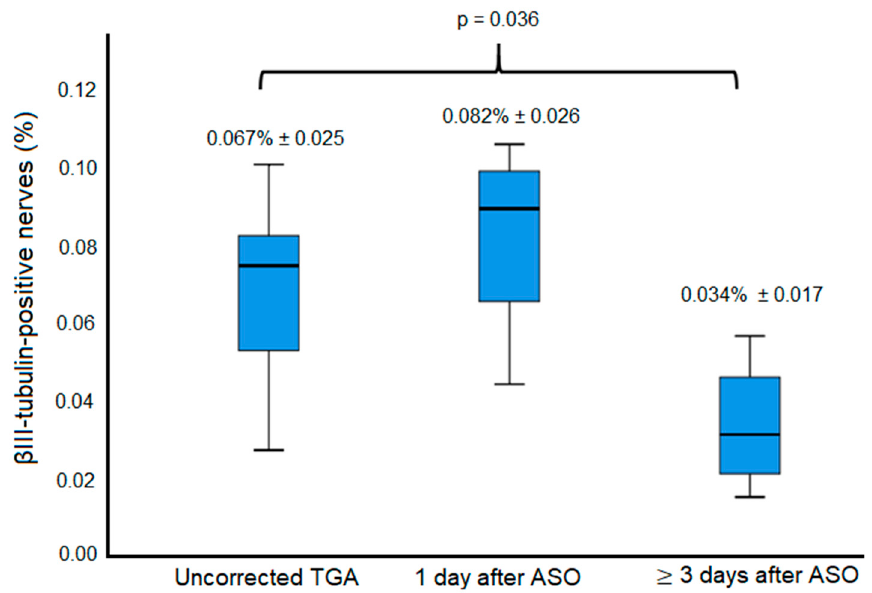
Figure 7. Comparison of β III-tubulin-positive nerves in TGA-ASO and uncorrected TGA. Boxplot: the mean amount of β III-tubulin-positive nerves between the control group (uncorrected TGA) (n = 8), TGA 1 day after ASO (n = 4), and TGA ≥ 3 days after ASO (n = 4). Abbreviations: ASO, arterial switch operation; TGA, transposition of the great arteries.